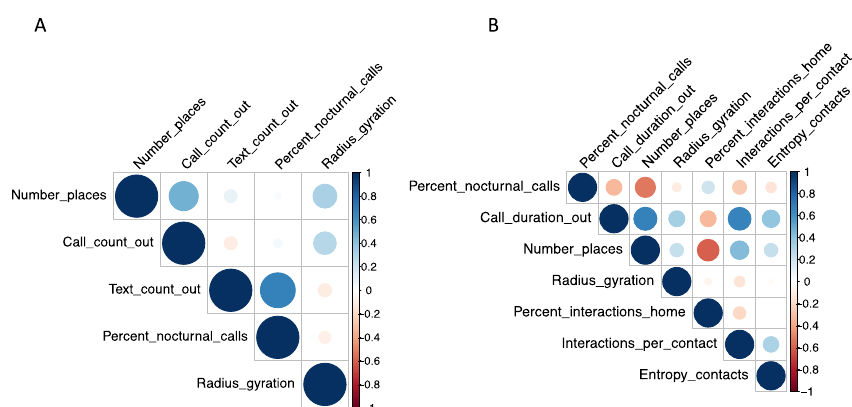
Fig. 2 Bivariate Pearson correlation plots for Namibia ( A ) and Nepal ( B ). These plots show all non-collinear CDR data from the input data detailed in Table 2. The variables shown here specify the model inputs for the full